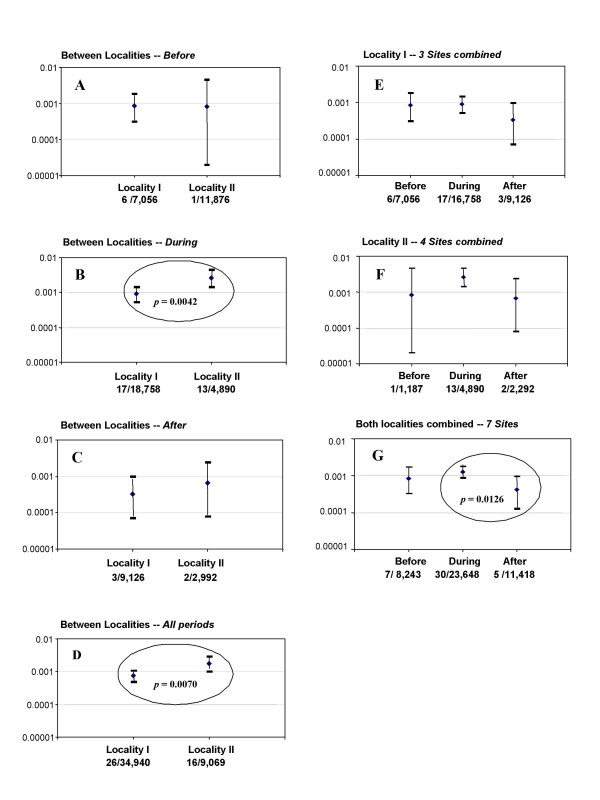
The prevalence of infection (with any Onchocerca volvulus larval stage) in Simulium ochraceum s.l. parous flies in localities I and II: A, before the arrival (April and October), B, during the stay (May through July and November through February), C, after departure (August and February) of temporary migrant workers in the coffee seasons of 1997–1998 and 1998–1999 in the Southern Chiapas onchocerciasis focus, Mexico. D compares localities I and II for all three periods combined; E and F compare, respectively within localities I and II, fly infection levels between the before, during, and after periods, and G compares the periods for both localities combined. Error bars denote 95% confidence intervals; ovals indicate statistical differences with associated p-values.